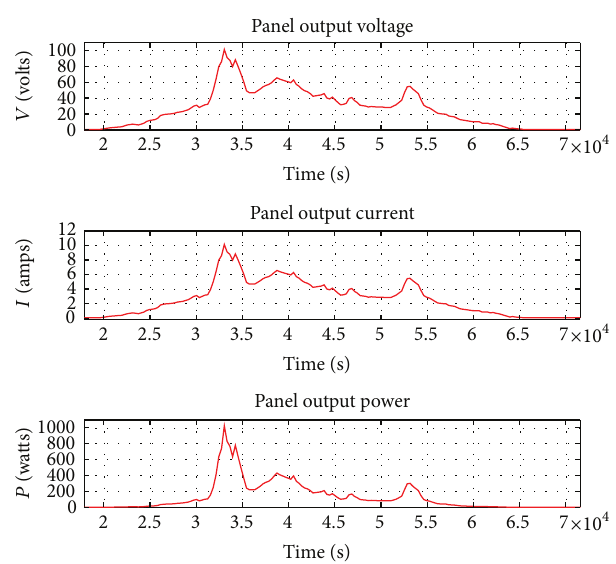
Figure 6: Voltage, current, and power output of simulated panel.